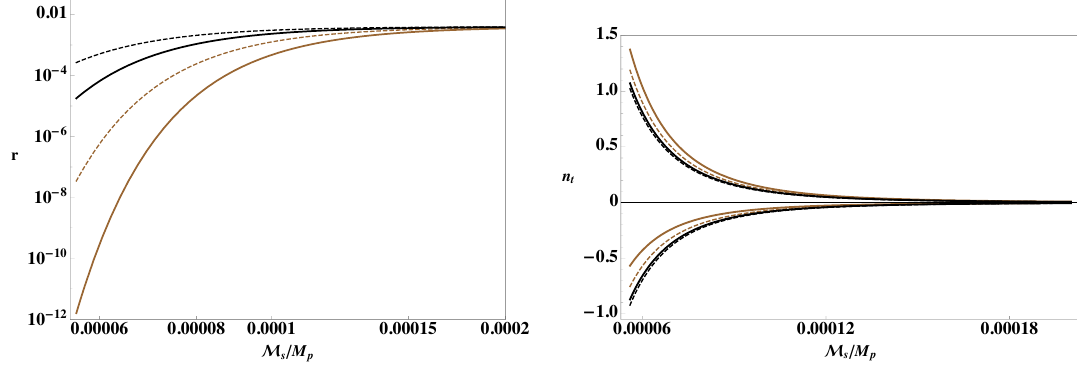
Figure 2 . In the above plots, we depict ( r; n t ) versus the scale of non-locality M s for the form- factor (3.19) and N (cid:3) = 55. We have taken (cid:11) 2 = 0 : 52 ; 0 : 28 ; 0 : 13 ; 0 : 065 (corresponding to brown full and dashed, black full and dashed lines respectively). In the right panel the lines with n t > 0 correspond to (cid:11) 1 = 2 : 5 and the lines with n t < 0 correspond to (cid:11) 1 = (cid:0) 2 : 5. In both the plots, we can notice that in the limit M s ! M p we recover the predictions of the local R 2